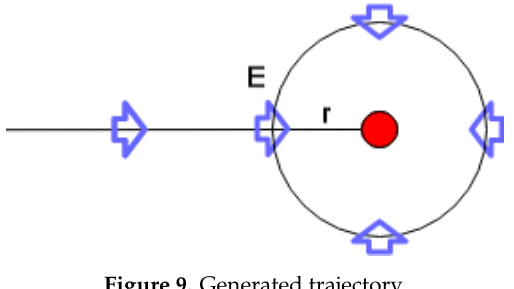
Figure 9. Generated trajectory.